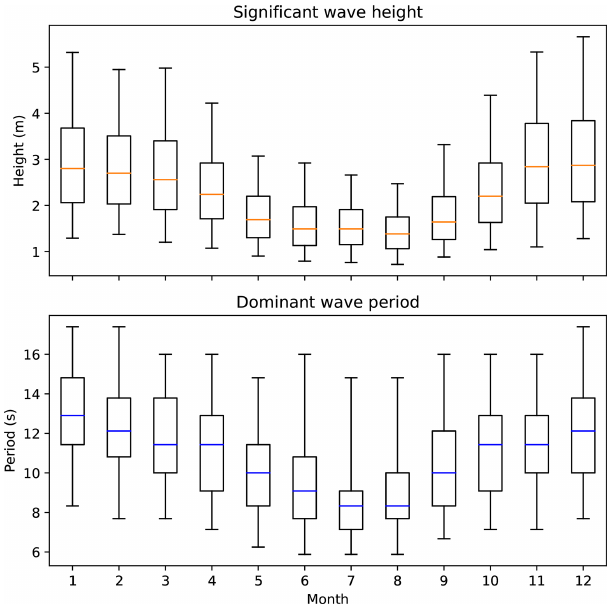
Figure 1. Significant wave height and peak wave period of the Pa- cific Northwest coasts (Washington, Oregon, and northern Califor- nia) from 2008–2018. Data include buoys 46041, 46029, 46050, 46015, and 46022. Boxes indicate 25th, 50th, and 75th percentiles, whereas whiskers indicate 5th and 95th percentiles (NOAA,